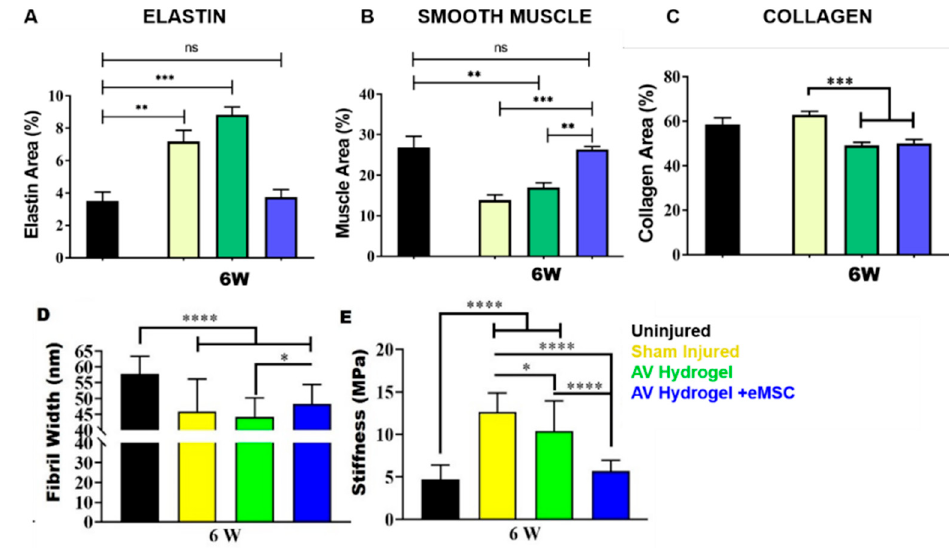
Figure 4. Impact of AV hydrogel therapeutic in birth injury treatment. The vaginal injection of AV hydrogel with and without endometrial mesenchymal stem cells (eMSCs) reverses the acute childbirth trauma as seen through vaginal tissue components such as ( A ) elastin, ( B ) smooth muscle cells and ( C ) tissue collagen. The AV-based treatment also shows nanoscopic changes in ( D ) collagen fibril width and ( E ) stiffness measured by atomic force microscopy. Statistical analysis one-way ANOVA with Tukey’s multiple comparisons test ( ∗ , p < 0.05, ∗∗ p < 0.01, ∗∗∗ p < 0.001, ∗∗∗∗ , p < 0.0001).Reproduced with permission from [54] , copyright Elsevier, 2021.